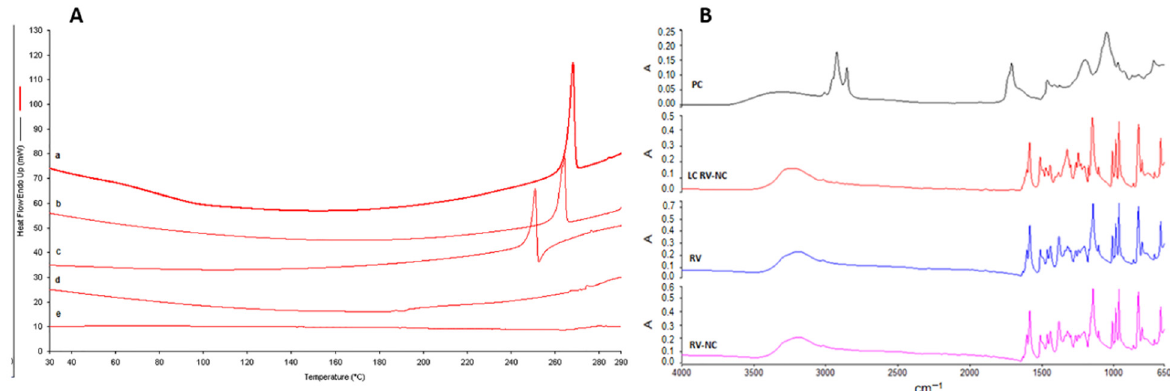
Figure 4. ( A ) Differential scanning calorimetry (DSC) thermograms of (a) trans -resveratrol (RV), (b) RV nanocrystals (RV-NC), (c) lipid-coated RV nanocrystals (LC RV-NC), (d) RV Phytosome ® and (e) phosphatidylcholine. ( B ) FTIR spectra of the coarse trans -resveratrol powder (RV), trans -resveratrol nanocrystals (RV-NC), lipid-coated trans -resveratrol nanocrystals (LC RV-NC) and phosphatidylcholine (PC).